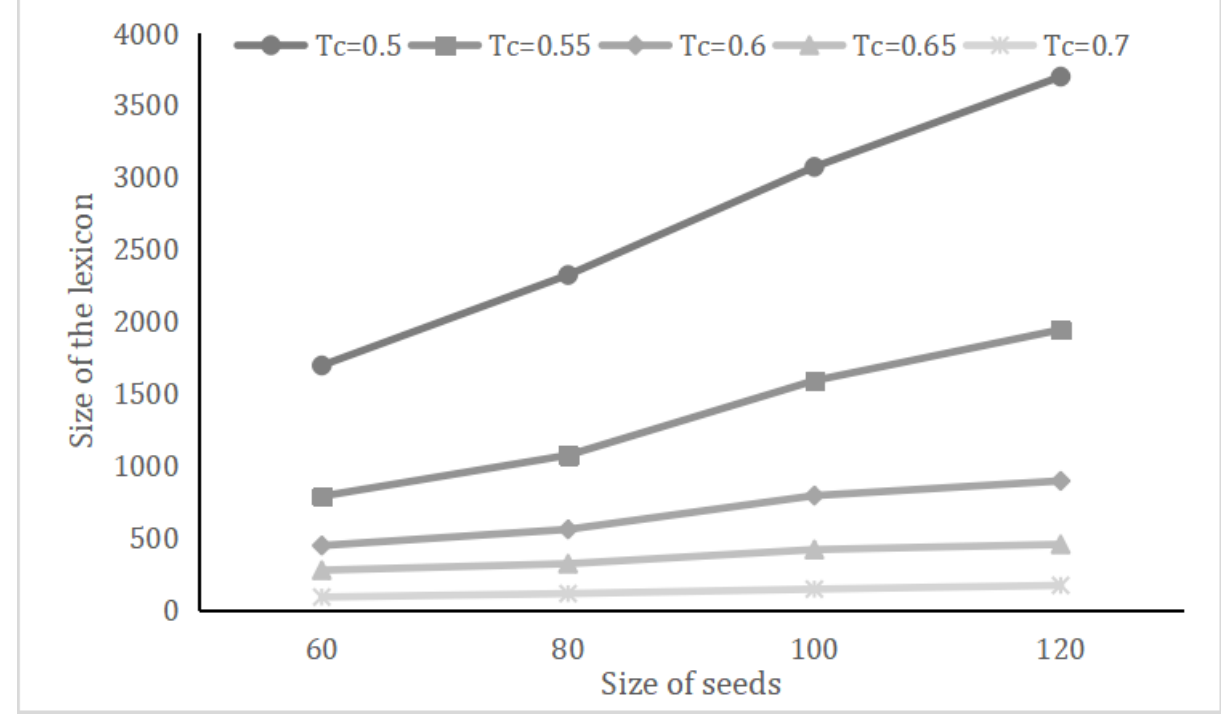
Figure 4. Size of the lexicon when the size of seeds and threshold for candidate words changed.